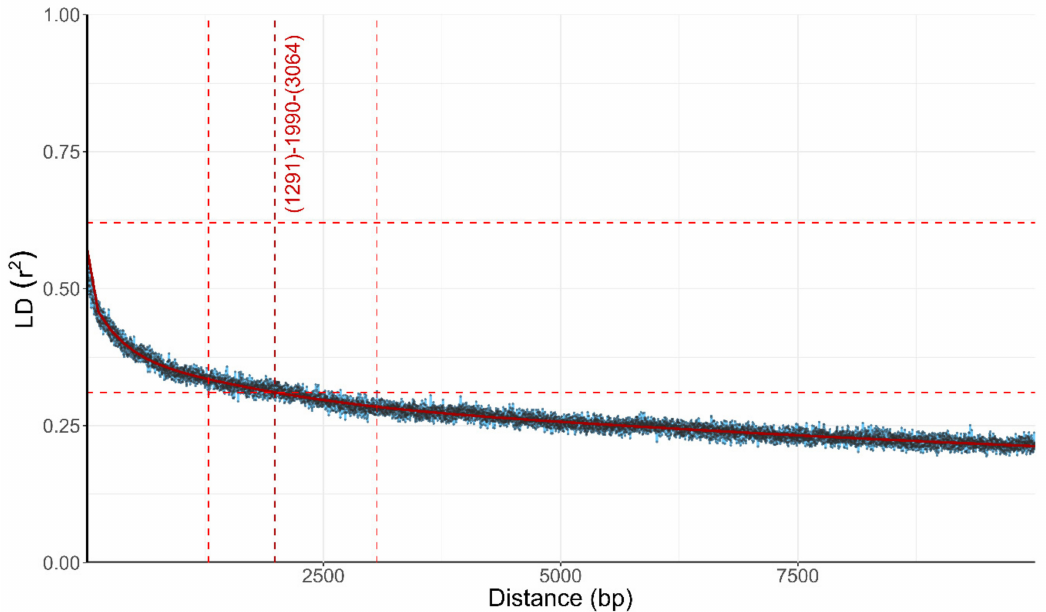
Figure 3. Linkage disequilibrium (LD) decay in Wallemia mellicola estimated by calculation of the squared correlation coe ffi cient ( r 2 ) between pairs of biallelic loci. r 2 is plotted against the physical distance of the loci in the genome. Horizontal lines mark the maximum observed value and half of the maximum observed value. Vertical lines mark the interval of the physical distance delimited by the first point of the curve under half of the maximum r 2 value (left vertical line), the last point above half of the maximum r 2 value (right vertical line) and the point where the fitted curve intersects with half of the maximum r 2 value (middle vertical